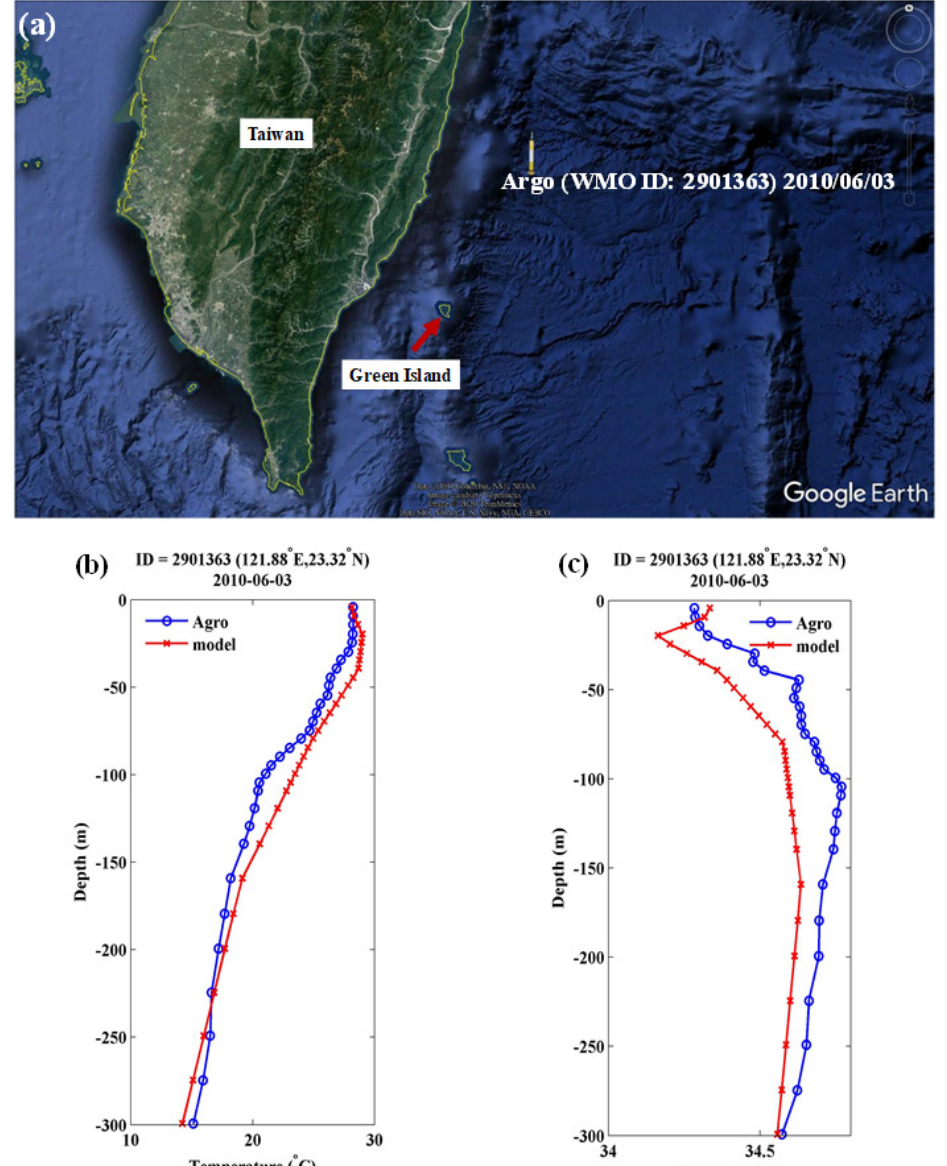
Figure 7. ( a ) Location of the Argo station as well as the measured; ( b ) temperature and ( c ) salinity profiles of the Argo data and the present